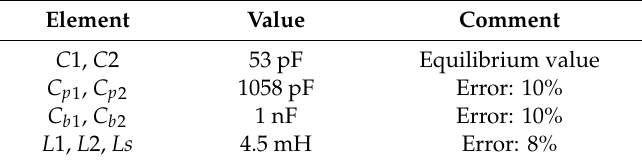
Table 2. Capacitances and inductances list.